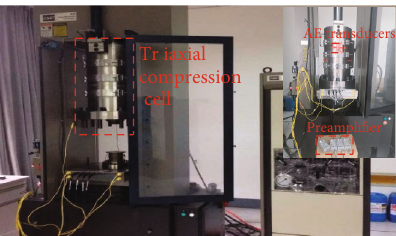
Figure 1: MTS815 Flex Test GT triaxial rock mechanics test system and Micro-II Digital AE